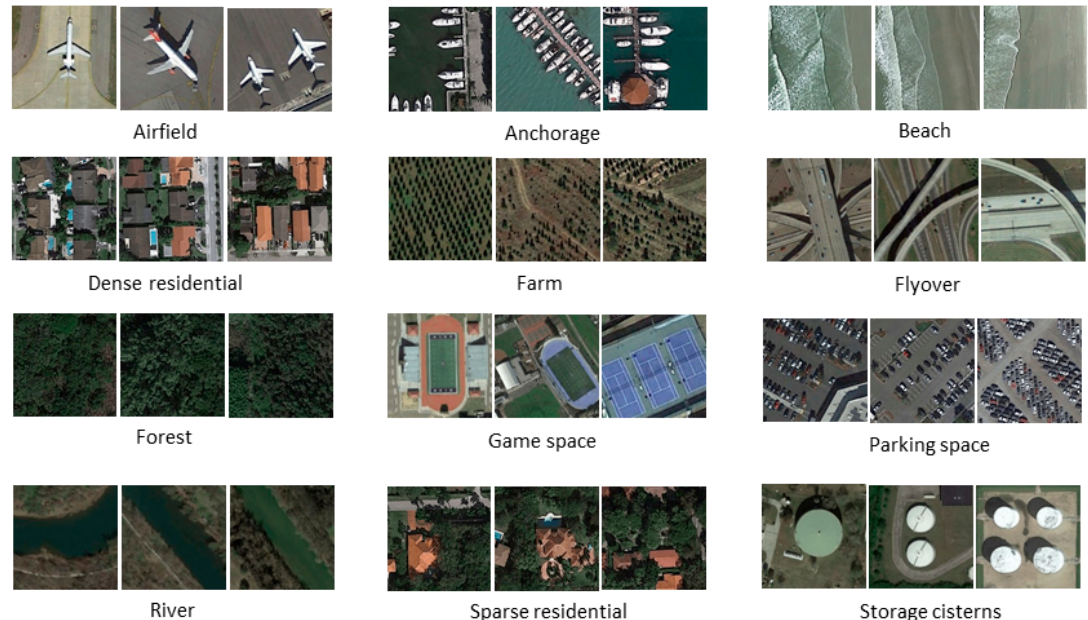
Figure 6. Example of images extracted from PattrenNet dataset.